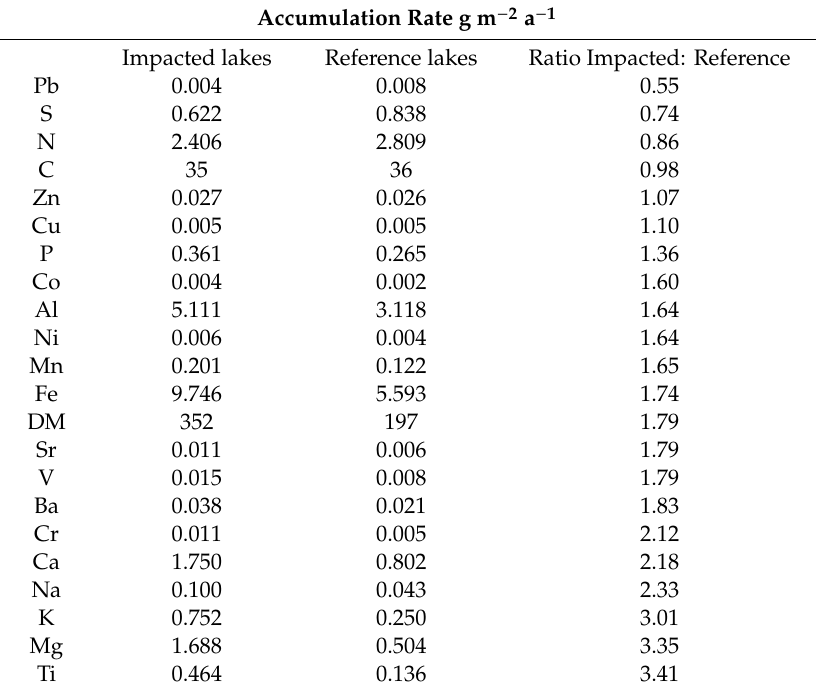
Table 2. Average post-1986 accumulation rates of certain elements in the impacted and reference lakes ( n = 44 lakes). Elements at the top of the table accumulate more rapidly in the reference lakes, while those at the bottom of the table accumulate more rapidly in impacted